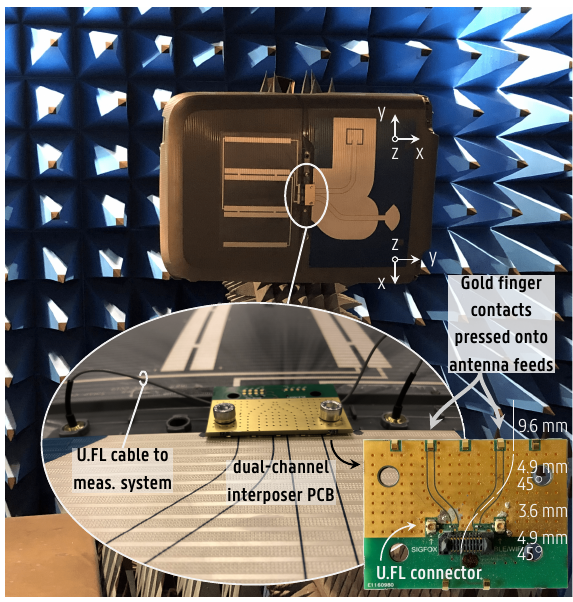
Figure 11. Setup used to measure the monopole and redesigned CPW patch antennas integrated by overmolding into the suitcase. The antennas are flush with the exterior of the suitcase shell. The structure on the left of the antennas is an interconnection pattern for solar cells (not implemented). Inset: dual-channel interposer PCB interconnecting the antennas. The interposer’s grounded coplanar waveguide (GCPW) lines, whose lengths are annotated, are jumpered to U.FL connectors. The coordinate system is oriented individually at each antenna, consistent with the coordinate system introduced in Figure